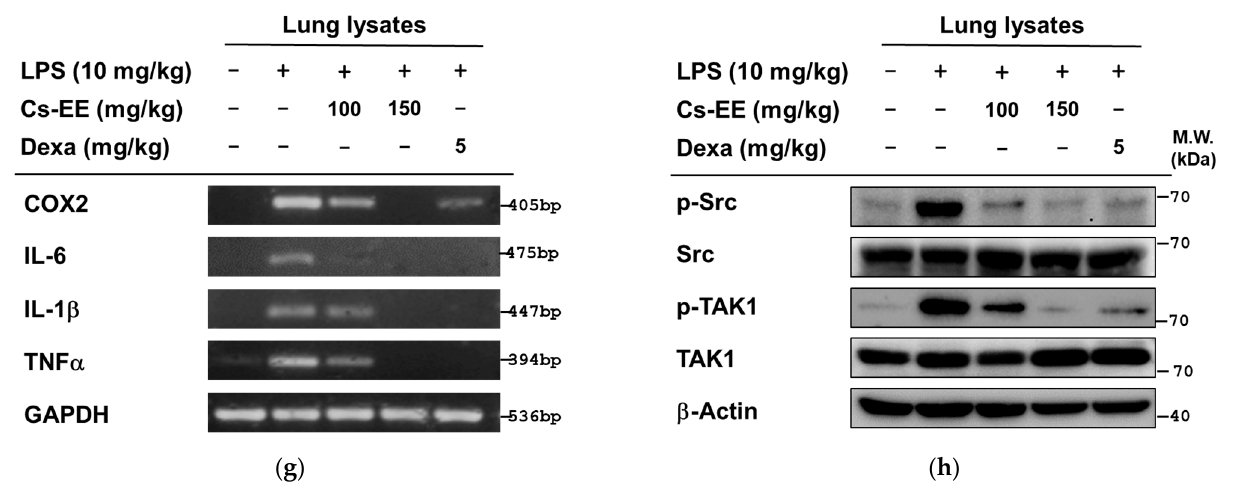
Figure 7. Effects of Cs-EE in the in vivo LPS-induced acute lung injury models. ( a ) Schematic of LPS-induced ALI protocol. C57BL/6 mice were orally treated with 100 μ L different solutions based on different groups: normal group (PBS), LPS group or as control group (PBS), Cs-EE groups (100 and 150 mg/kg Cs-EE) and dexa group (5 mg/kg dexa). Acute lung injury was induced by 50 μ L intranasal LPS (10 mg/kg) and mice were sacrificed after 12-16 h. ( b ) The severity of pulmonary edema was evaluated by measuring the lung wet/dry ratio. ( c – f ) The representative histopathological examination of lung tissue (H&E staining) was viewed with 100× or 400× magnification (c and d). The control group showed the thickest of alveolar walls than others; a black arrow indicates neutrophils infiltration, red arrow: hyaline membrane. Histologic ALI scoring system criteria (e) were calculated as follows: [(20 × A) + (14 × B) + (7 × C) + (7 × D) + (2 × E)]/(number of fields × 100) (n field = 4). Proteinaceous debris filling the airspaces were considered as none due to the short time dosage. The histology score analyses of acute lung injury were determined using the indicated parameters (f). ( g ) The expression of inflammatory genes in lung lysates was analyzed by semiquantitative RT-PCR. ( h ) The phospho- and total forms of Src, TAK1, and β -actin were evaluated by immunoblot analysis. Results (b and f) are expressed as mean ± SD (n = 4–5). ## p < 0.01 and #### p < 0.0001 compared to normal group by the student’s t -test, and * p < 0.05, ** p < 0.01 and *** p < 0.001 compared to control group (inducer alone) by one-way ANOVA.